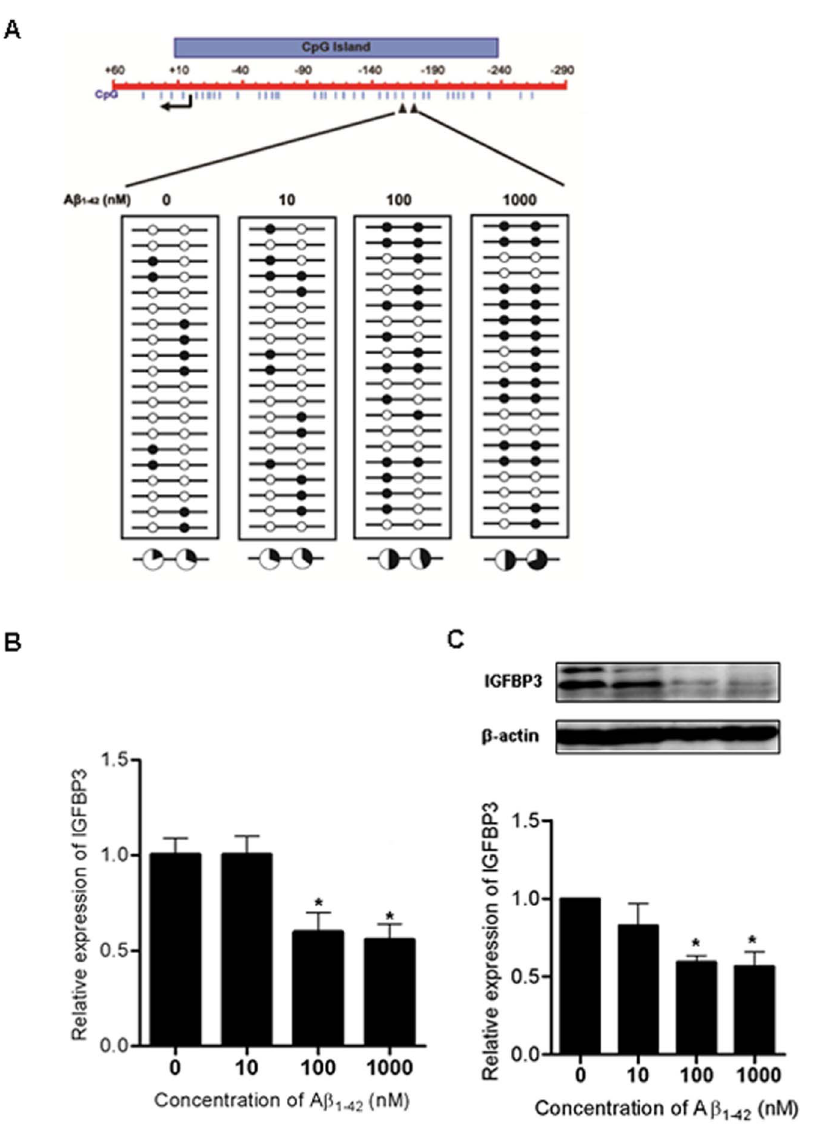
Figure 5. CpG island methylation is altered in the IGFBP3 promoter region in H4 cells treated with A b 1 – 42 H4 cells were treated for 5 days with different concentrations of A b 1 – 42 . DNA methylation at the -164 and -173 CpG sites was analyzed using bisulfite sequencing analyses (A). Each circle represents CpG dinucleotides. The methylation status of each CpG site is illustrated by black (methylated) and white (unmethylated) circles. The total percentage of methylation at specific CpG sites is indicated as a pie graph. The black segment of the pie graph indicates methylated CpG percentage whereas the white segment represents the unmethylated CpG percentage (A). IGFBP3 expression after treatment with A b 1 – 42 was determined using qPCR (B) and western blot analyses (C). Graphs depict compiled data from three independent experiments and values are relative to those of untreated controls. Data are shown as the mean 6 SD (n=3). Statistical analyses were performed using one-way ANOVA and Bonferroni post-tests (* indicates p ,